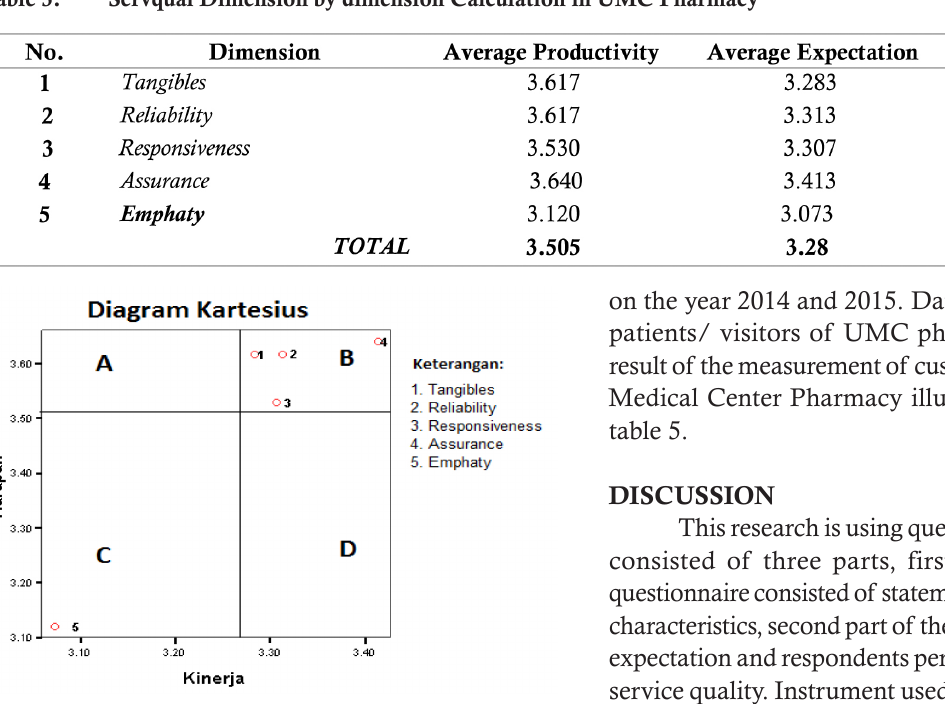
Servqual Dimension by dimension Calculation in UMC Pharmacy